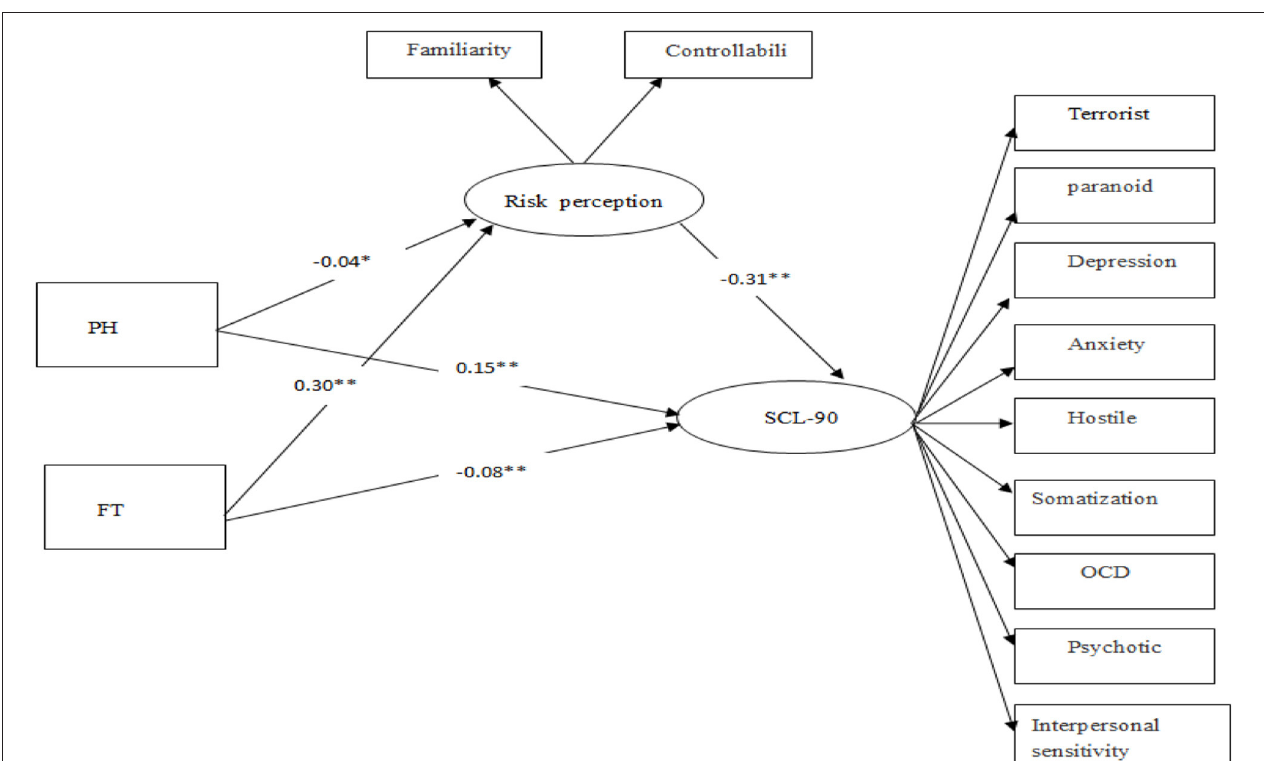
FIGURE 1 | Final model showing moderated mediation; RP mediates TP effect on MH. * p < 0.05, ** p < 0.01.